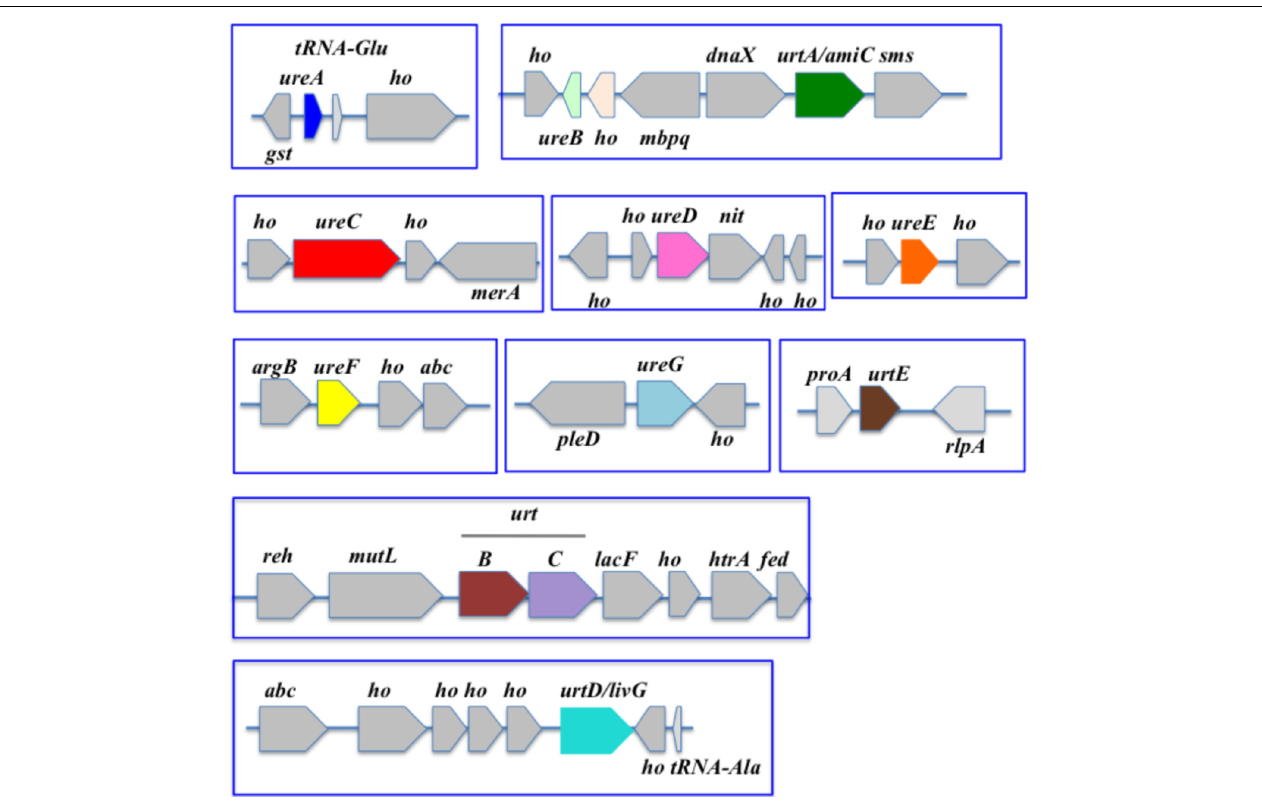
FIGURE 3 | Organization of the urea acquisition and catabolism genes in Synechocystis PCC 6803. The genes are shown as colored boxes pointing in the direction of their transcription. Gray boxes correspond to genes not known to be involved in urea metabolism or transport. abc , ABC transporter; argB , acetylglutamate kinase; abc , ABC transporter; dnaX , DNA polymerase III subunit delta; fed , ferredoxin; gst, glutathione-S-transferase; ho, hypothetical protein; htrA , serine protease; lacF , lactose ABC transporter permease; mbpq, methyl-6-phytyl 1,4-hydroquinone methyltransferase; merA, mercuric reductase; mutL , DNA mismatch repair; nit, nitrilase; pleD , pleD protein; proA , gamma-glutamyl phosphate reductase; radA homolog; reh, rehydrin; rlpA , rare lipoprotein A; sms, DNA repair